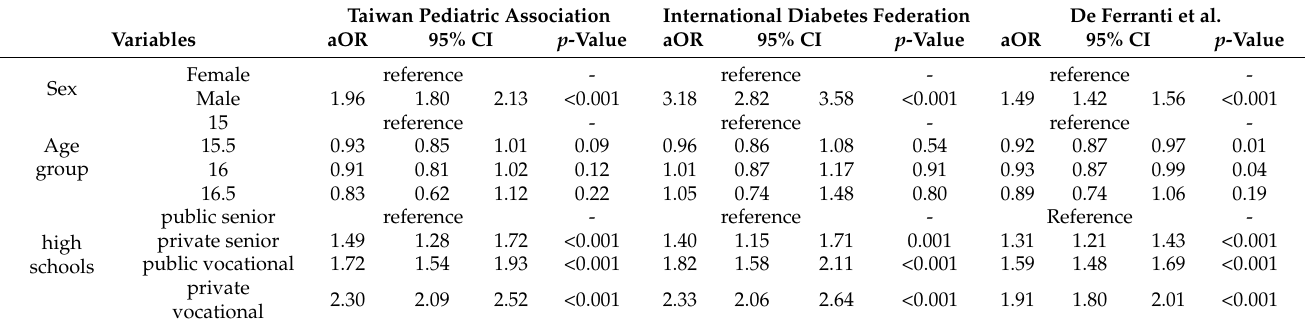
Table 4. Adjusted odds ratios of adolescents having metabolic syndrome as defined by different criteria. Taiwan Pediatric